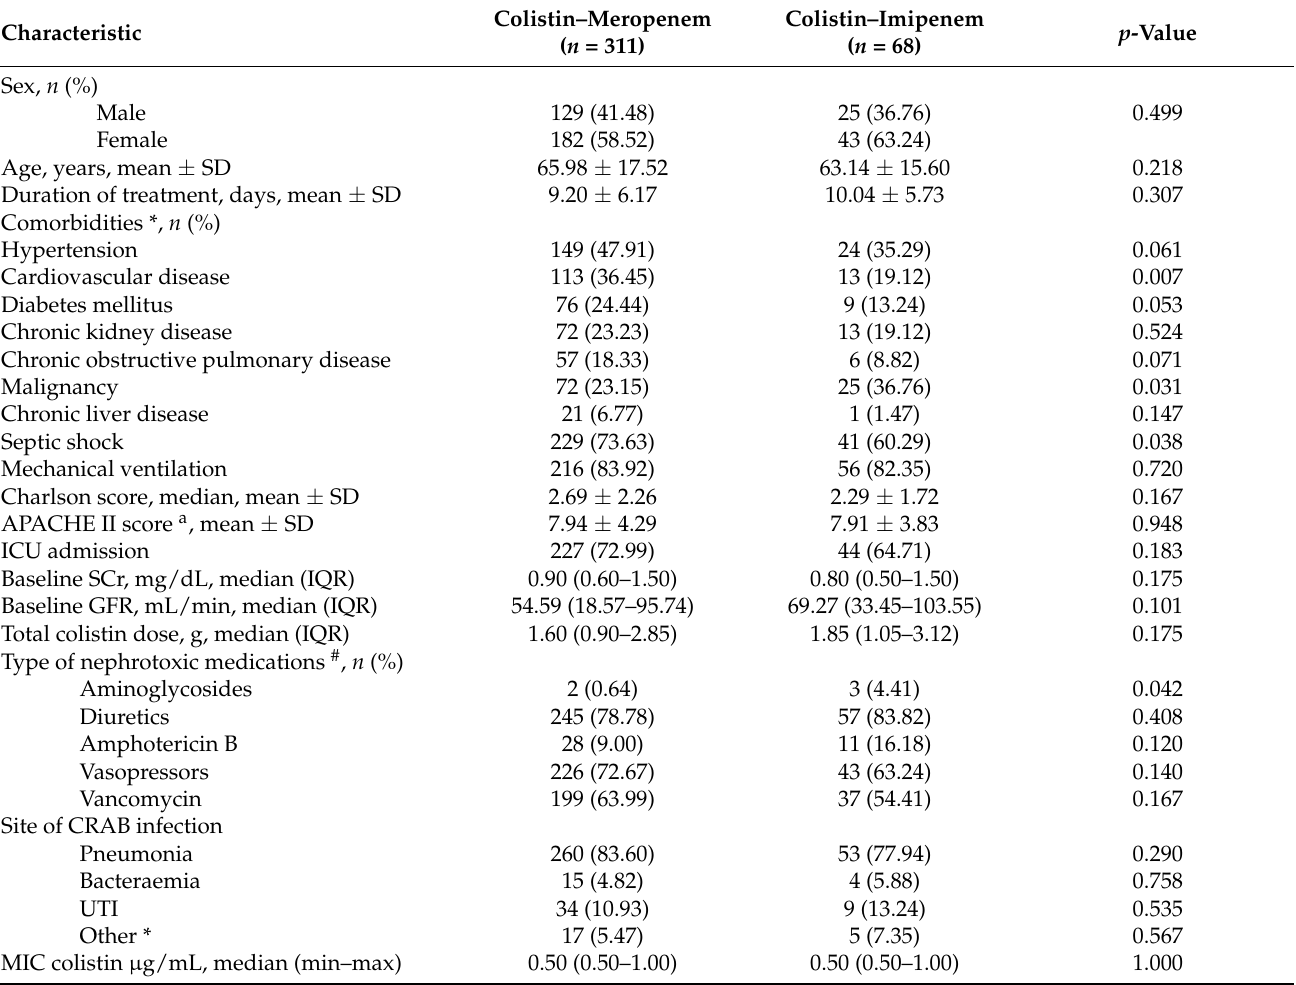
Table 1. Demographic and clinical characteristics of patients who received LD colistin–meropenem compared with LD colistin–imipenem